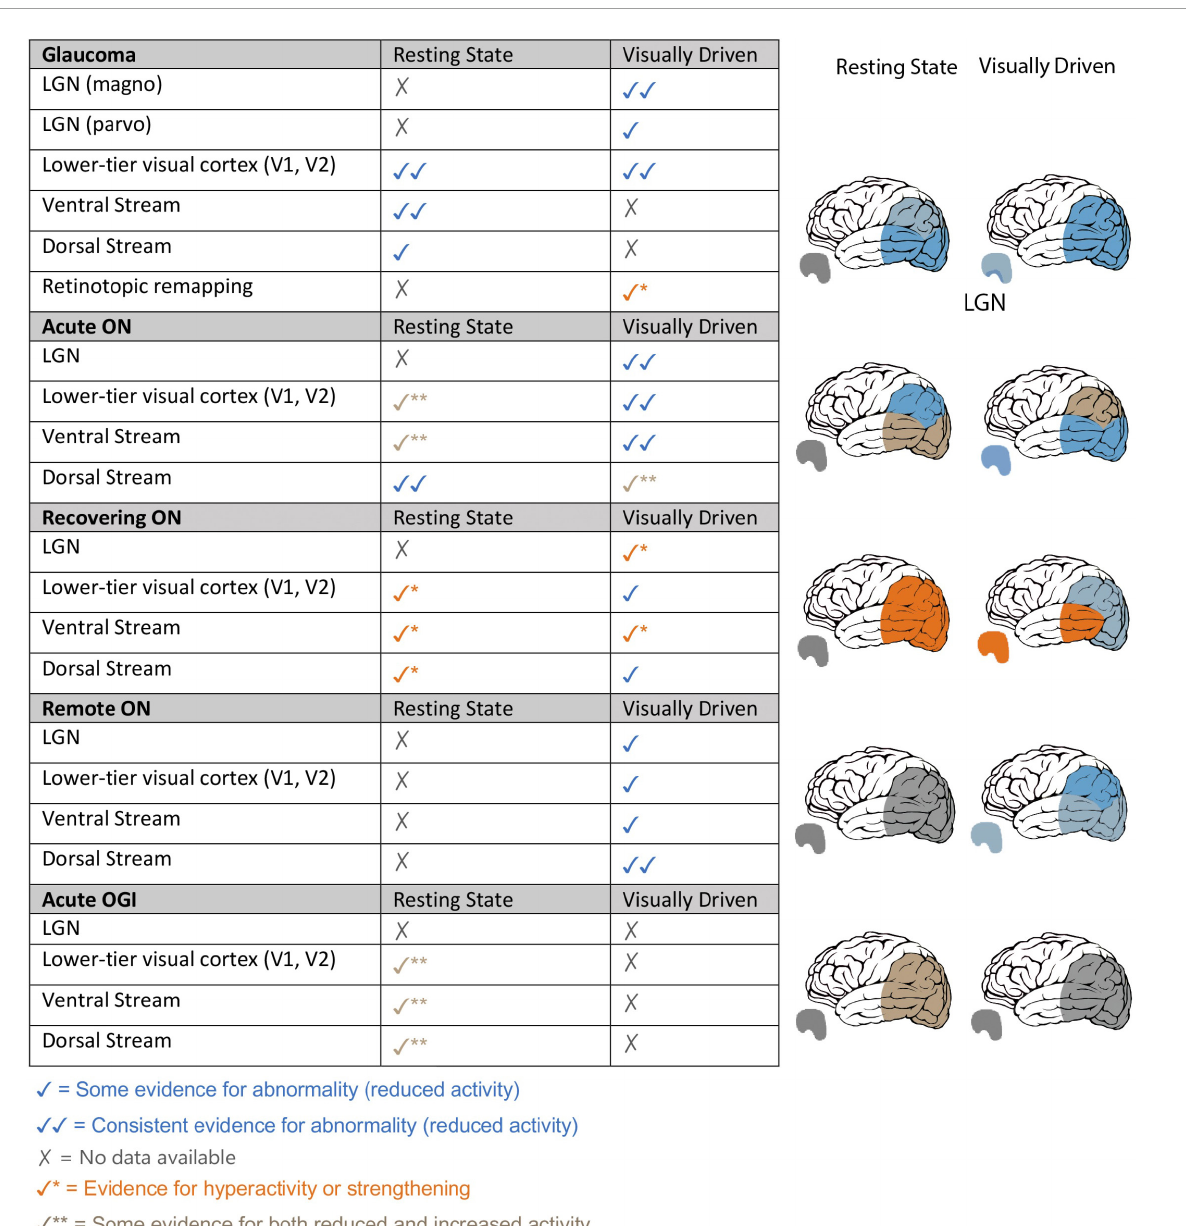
FIGURE1 Summary of resting-state and visually driven fMRI findings in Glaucoma, Optic Neuritis and Traumatic Optic Neuropathy. Left: fMRI findings of glaucoma, ON and (TON-like) OGI patients are summarized based on visual areas that were investigated and themes that were revealed in our analysis of visually driven and RS-fMRI literature of each optic neuropathy. Findings from rapidly changing optic neuropathies such as ON and OGI have been split into three stages of the disease: acute – within 1 month of disease onset, recovering – 3–4 months from disease onset, and remote –1 year or more since disease onset. Right: pictorial representation of the fMRI findings within LGN and visual cortical areas, specifically lower visual areas, dorsal visual stream and ventral visual stream, for glaucoma patients, ON patients at different stages of the disease and OGI